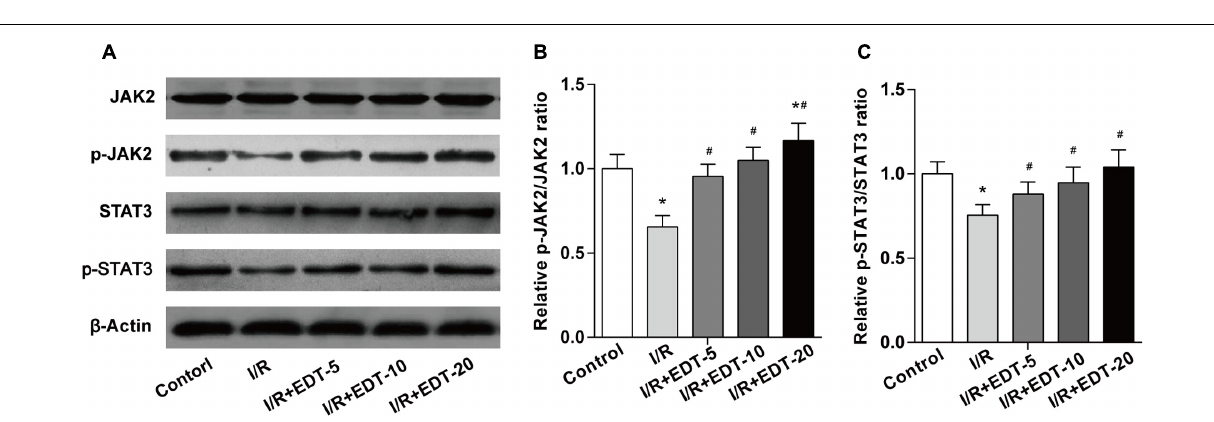
FIGURE 4 | Eriodictyol treatment elevates the JAK2 activation. (A) The protein levels of JAK2, p-JAK2, STAT3, and p-STAT3 in cardiac tissues were measured by western blot. Statistical analysis of p-JAK2/JAK2 ratio (B) and p-STAT3/STAT3 ratio (C) in cardiac tissues. n = 4 per group. The protein ratios were normalized to the values of the control group. All data are the mean ± SD. ∗ P < 0.05 compared with control group, # P < 0.05 compared with I/R